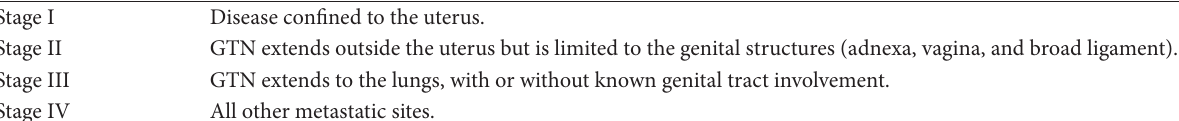
Table 1: (a) FIGO 2000 classification for GTN-staging system. (b) FIGO 2000 classification for GTN-risk scoring